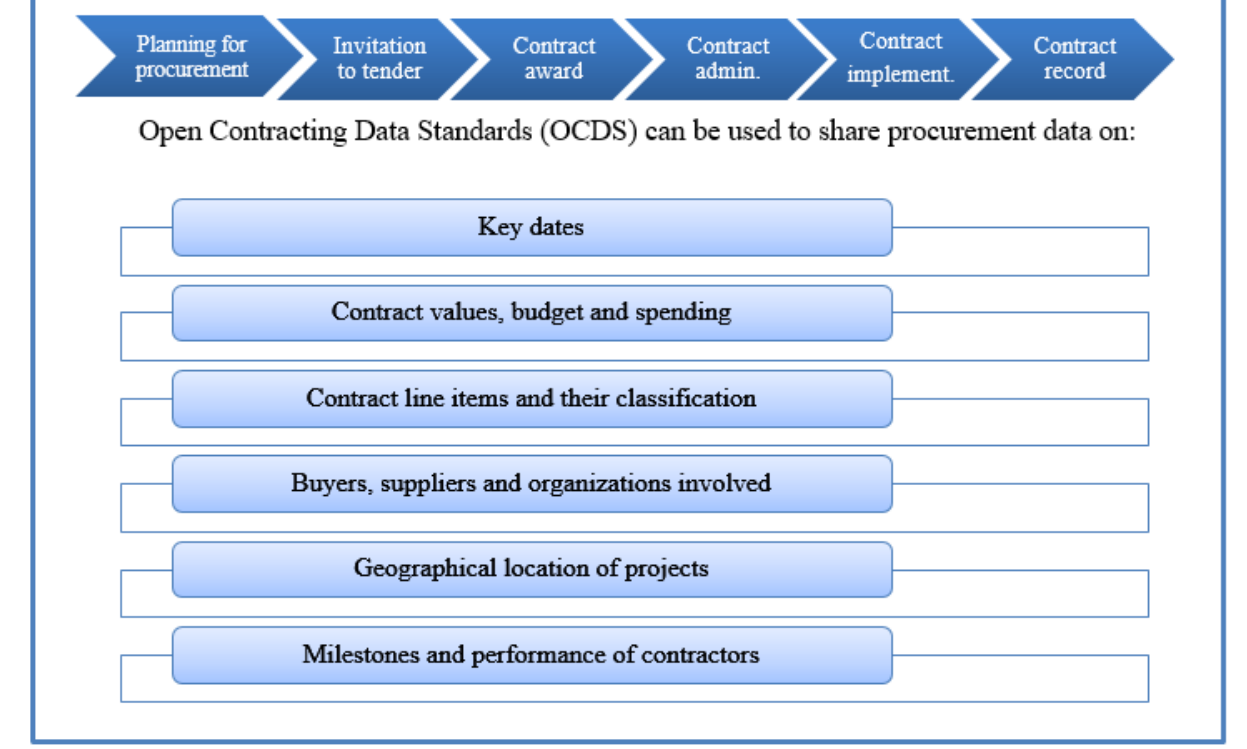
Figure 1. Application of Open Contracting